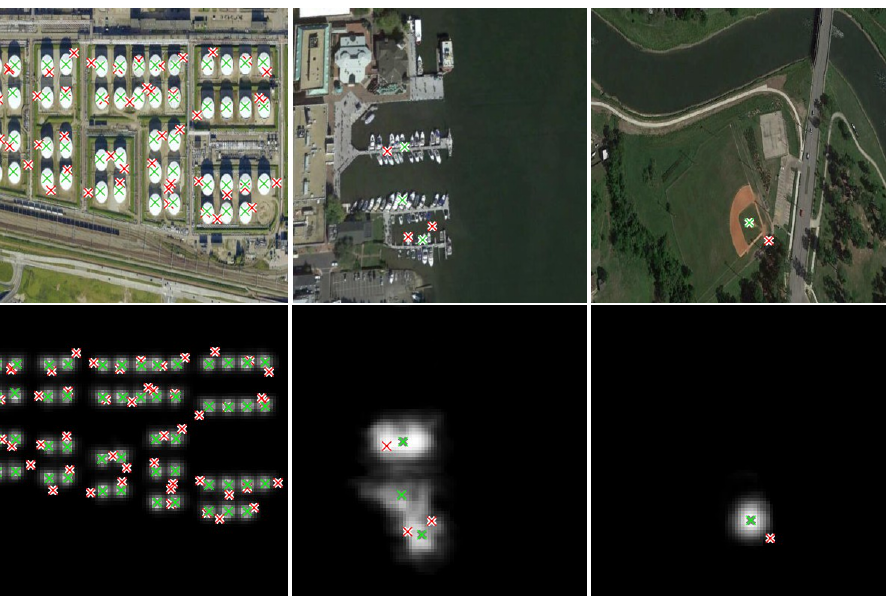
Figure 5. Example images, class activation maps, and object labels from the NWPU VHR-10 dataset. Noisy and refined labels are marked with red and green crosses, respectively. Best viewed in